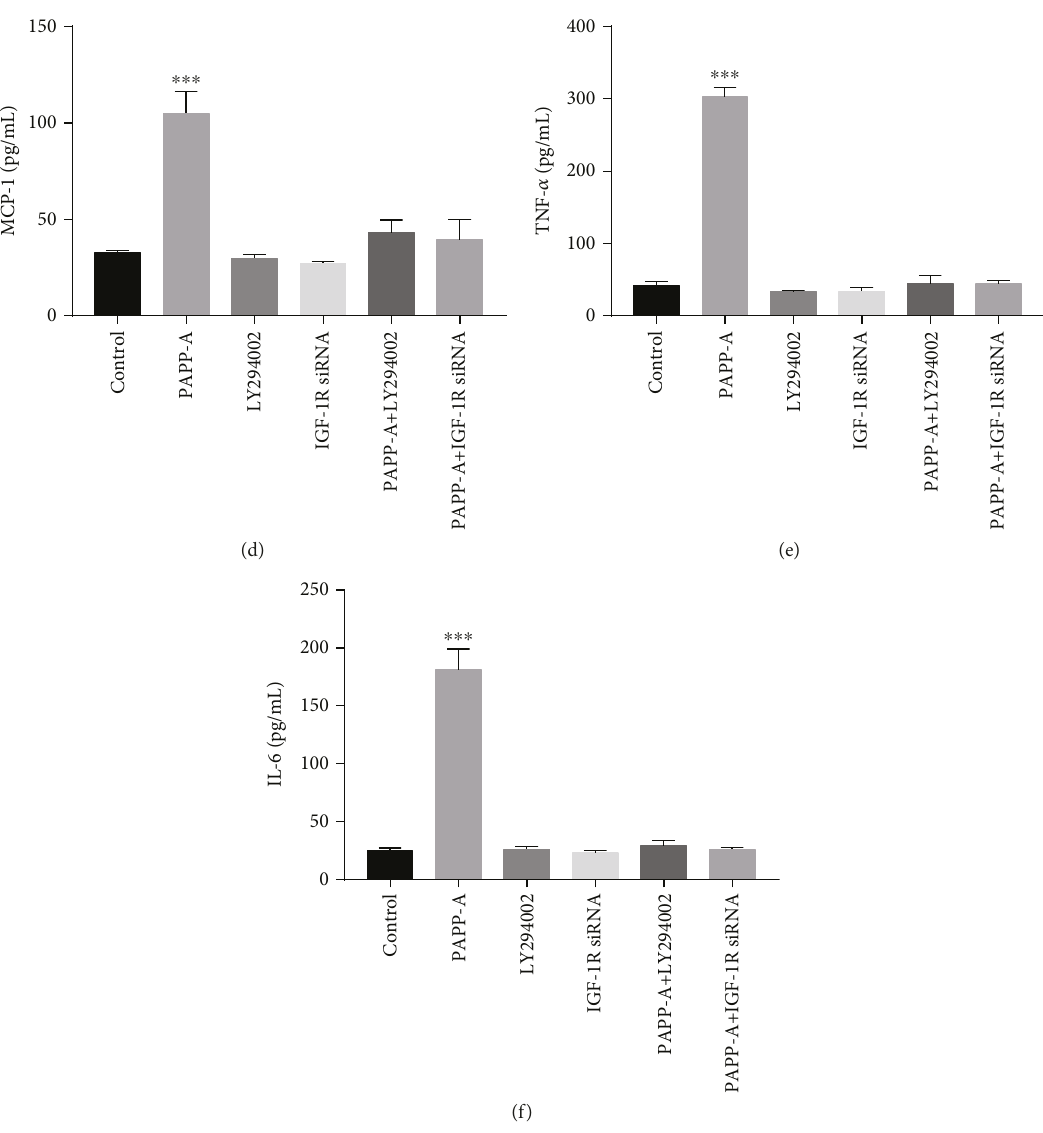
Figure 4: Upregulation of MCP-1, TNF- α , and IL-6 expressions and productions by PAPP-A is dependent on the IGF-I/PI3-K/Akt signaling pathway in RAW264.7 macrophages. Cells were incubated for 24 h in the presence (+) or absence ( − ) of PAPP-A (200ng/mL) with (+) and without ( − ) LY294002 (10 μ M). In addition, RAW264.7 macrophages were transfected with control or IGF-IR siRNA and then incubated with PAPP-A (200ng/mL) for 24 h. Total RNA was extracted, and RT-qPCR was performed to determine the expression of MCP-1, TNF- α , and IL-6 mRNA (A), and Western immunoblotting assays were conducted for protein expression of MCP-1, TNF- α , IL-6, and β -actin (b, c), and then ELISA were used to estimate MCP-1, TNF- α , and IL-6 concentrations in the culture medium (d, e, f). Similar results were obtained in three independent experiments. Data are the mean + SD . ∗∗∗ P < 0 001 vs.